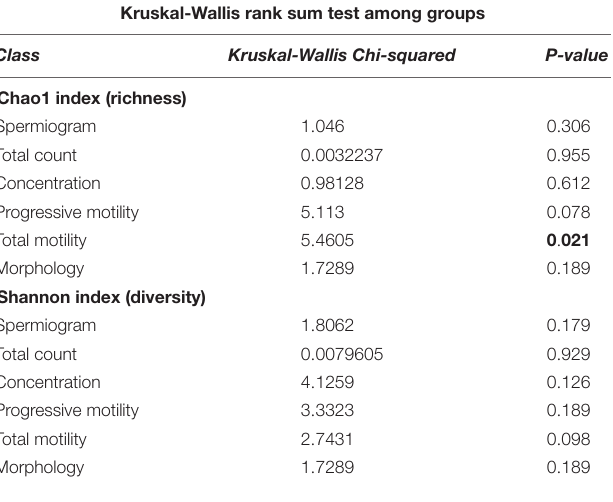
TABLE 2A | Summary of alpha diversity analyses.